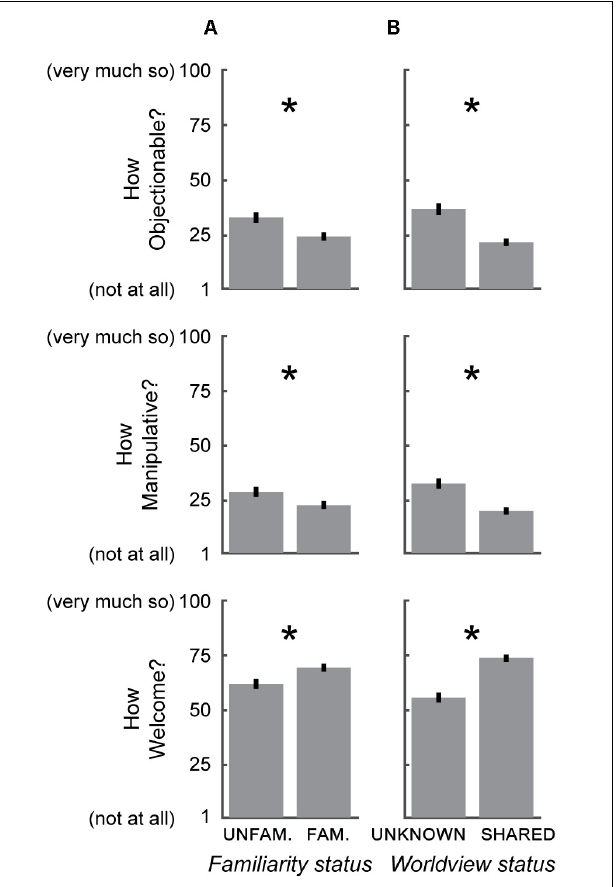
FIGURE 3 | Effect sizes between and across rationality status and preauthorization status conditions. (A) Effect sizes (Cohen’s d) between groups’ (squares) perceptions of the extent to which the influence was perceived as Objectionable in the voting scenario. Shading corresponds to mean group response. NON - P . A ., NON - PREAUTHORIZED ; P . A ., PREAUTHORIZED . (B,C) As in A , for the extent to which the influence was perceived as Manipulative (B) and Welcome (C) . (D–F) As in (A–C) , for the healthy eating scenario.